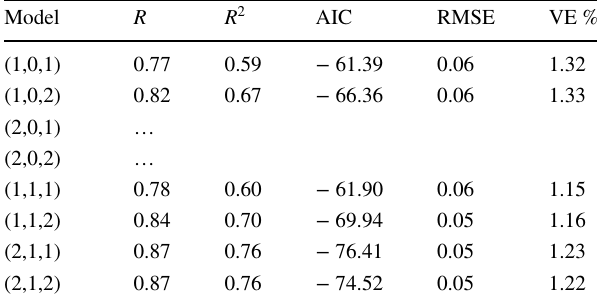
Fig. 7 Unchanging time arrangement of Ca2 + and the foretold values for 5 years